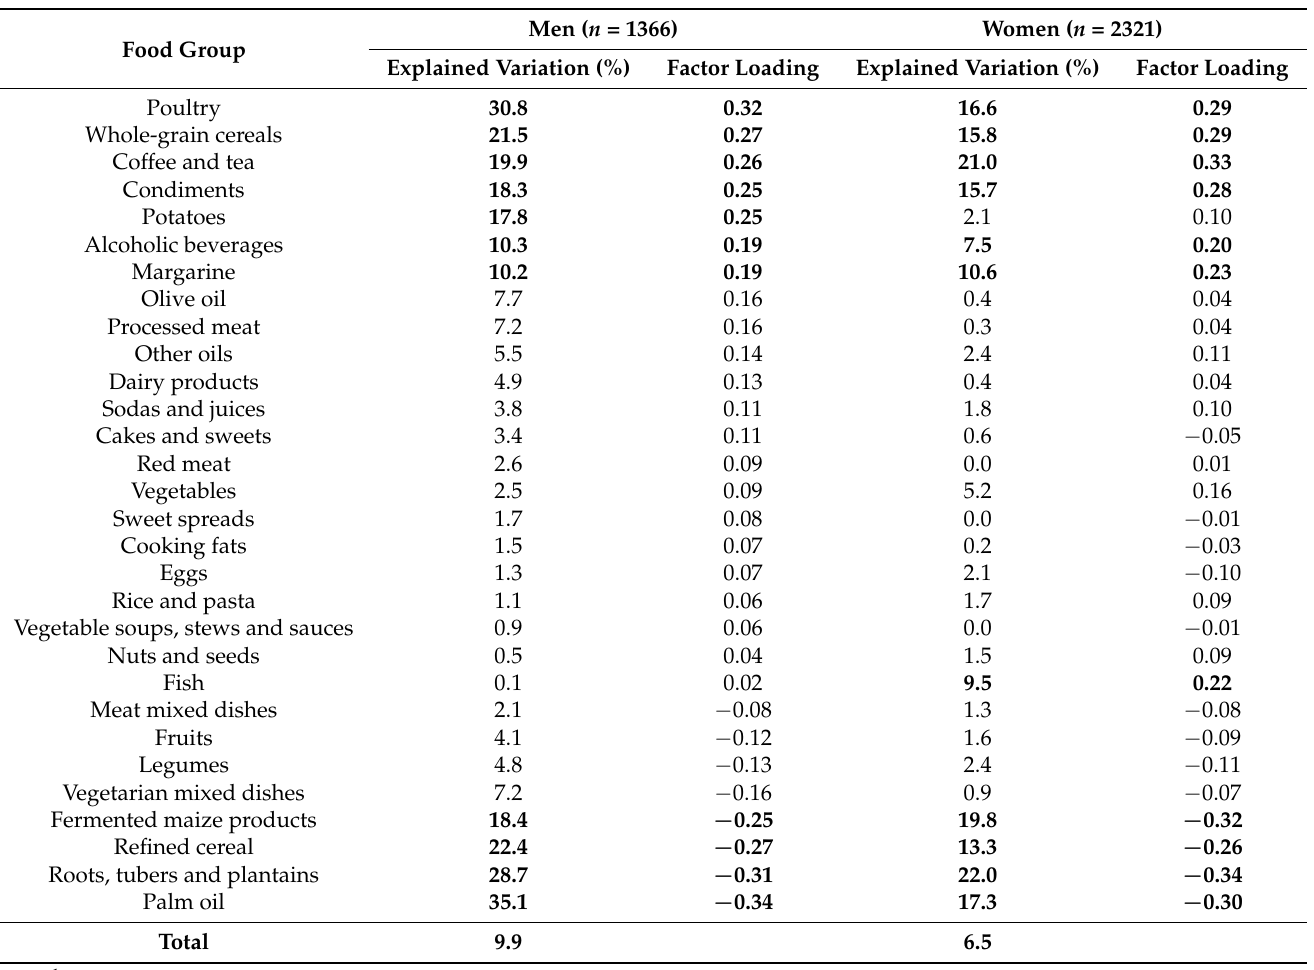
Table 2. Percentage of explained variation in food intake and factor loadings of 30 food groups of the RRR-derived dietary pattern scores related to the FLI for males and females 1